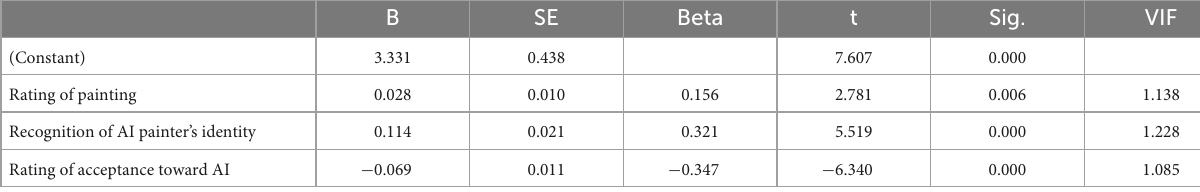
TABLE 5 Multiple regression results of willingness to use AIGC for painting.